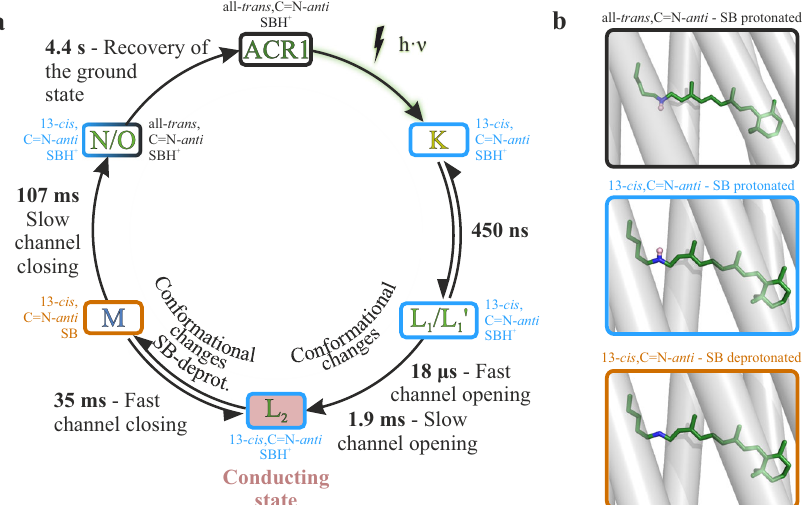
Fig. 4 Revised photocycle model of Gt ACR1. a The extended photocycle model is based on our ambient temperature time-resolved FTIR-spectroscopic data (Fig. 2) along with our UV/VIS spectroscopic data (Supplementary Fig. 4) and previously published electrophysiological measurements 32 . The K to L transition precedes channel opening indicating a non-conducting L 1 state. Channel opening occurs in a two-step process with a fast (18 µ s) and a slow (1.9 ms) opening process to the conducting state L 2 (red). Therefore, L 1 was subdivided into L 1 and L 1 ’ . The possible kinetic correlations of L 1 and L 2 are